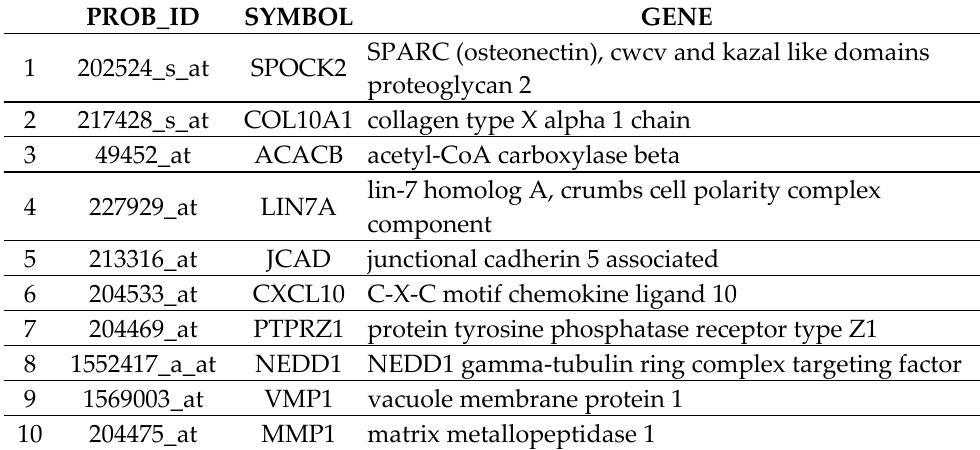
Table 3. Table of top 10 candidate differentially expressed genes identified with C5.0 decision tree model.